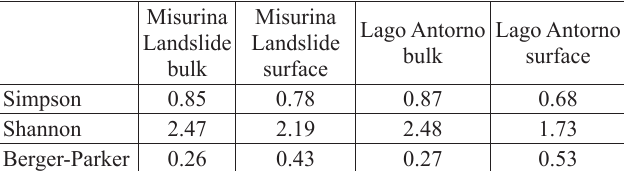
Table 3. Diversity indices of bulk and surface samples from Misurina Landslide and Lago